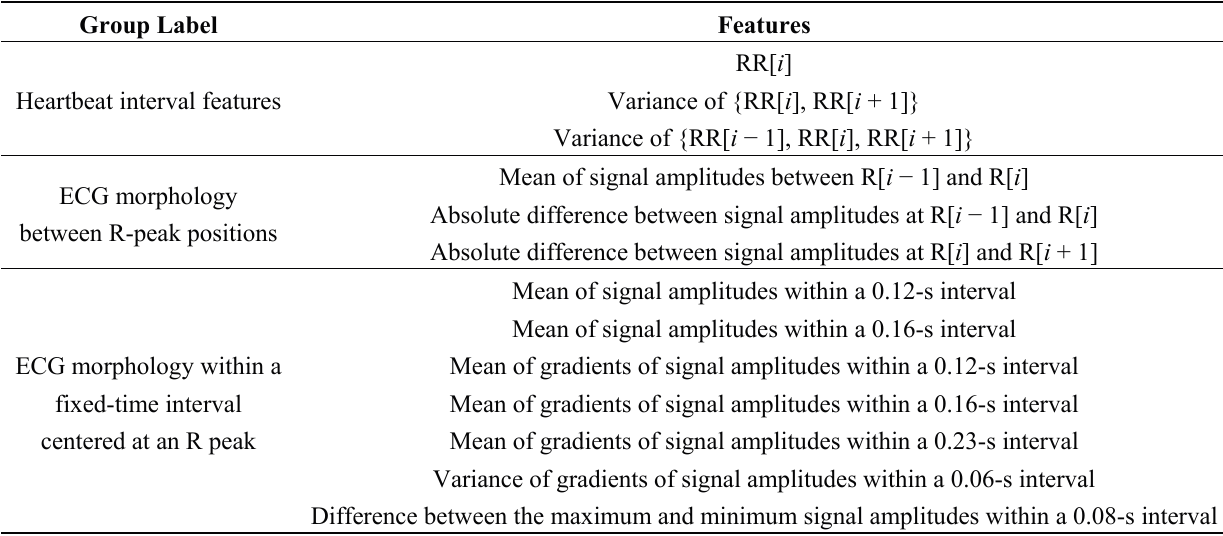
Table 3. R-peak-based features used for arrhythmia classification.